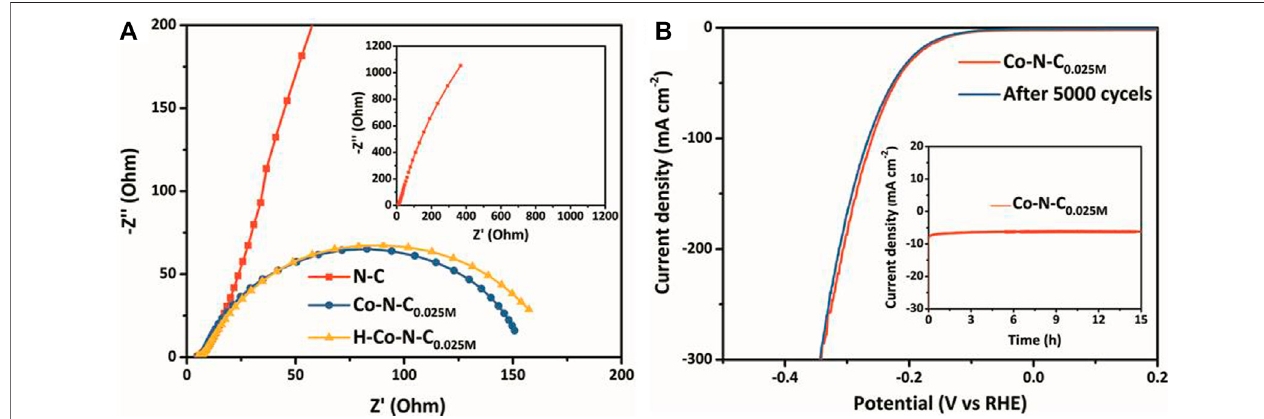
FIGURE 5 | (A) Nyquist plots of Co-N-C 0.025M , H-Co-N-C 0.025M , and N-C. (B) LSV curves of Co-N-C 0.025M original and after 5,000 cycles; inset: time-dependent current density curve of Co-N-C 0.025M in 0.5 M H 2 SO 4 under an overpotential of 145